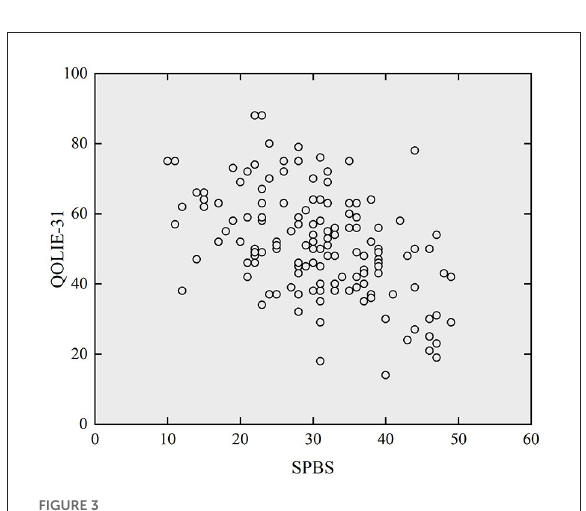
FIGURE3 Scatterplot of SPBS versus QOLIE-31 (N = 143).